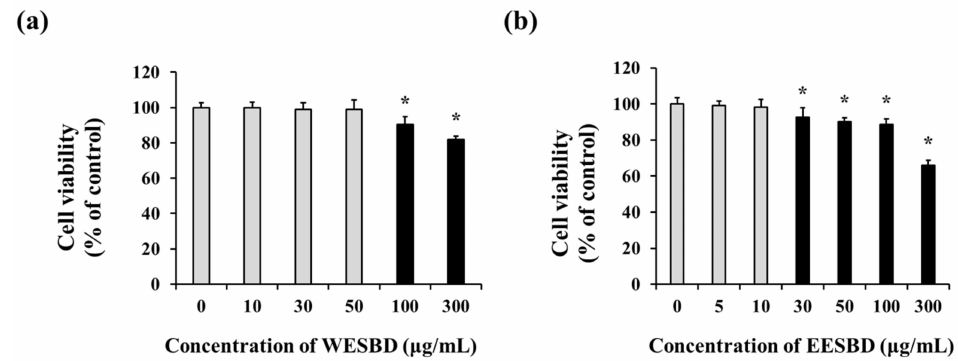
Figure 1. Cytotoxicity assay of water extract of S. barbata D. Don (WESBD) and ethanol extract of SBD (EESBD) in NIH-3T3 skin fibroblast cells. Various concentrations of WESBD (0–300 µ g/mL) ( a ) and EESBD (0–300 µ g/mL) ( b ) were added to NIH-3T3 cells cultured in a 96-well plate and then incubated for 24 h at 37 ◦ C in a CO 2 incubator. The experiments were repeated three times, with similar results. A representative result is shown. Data are presented as the mean ± SD. *: Indicates a significant difference ( p < 0.05) compared with the control (no